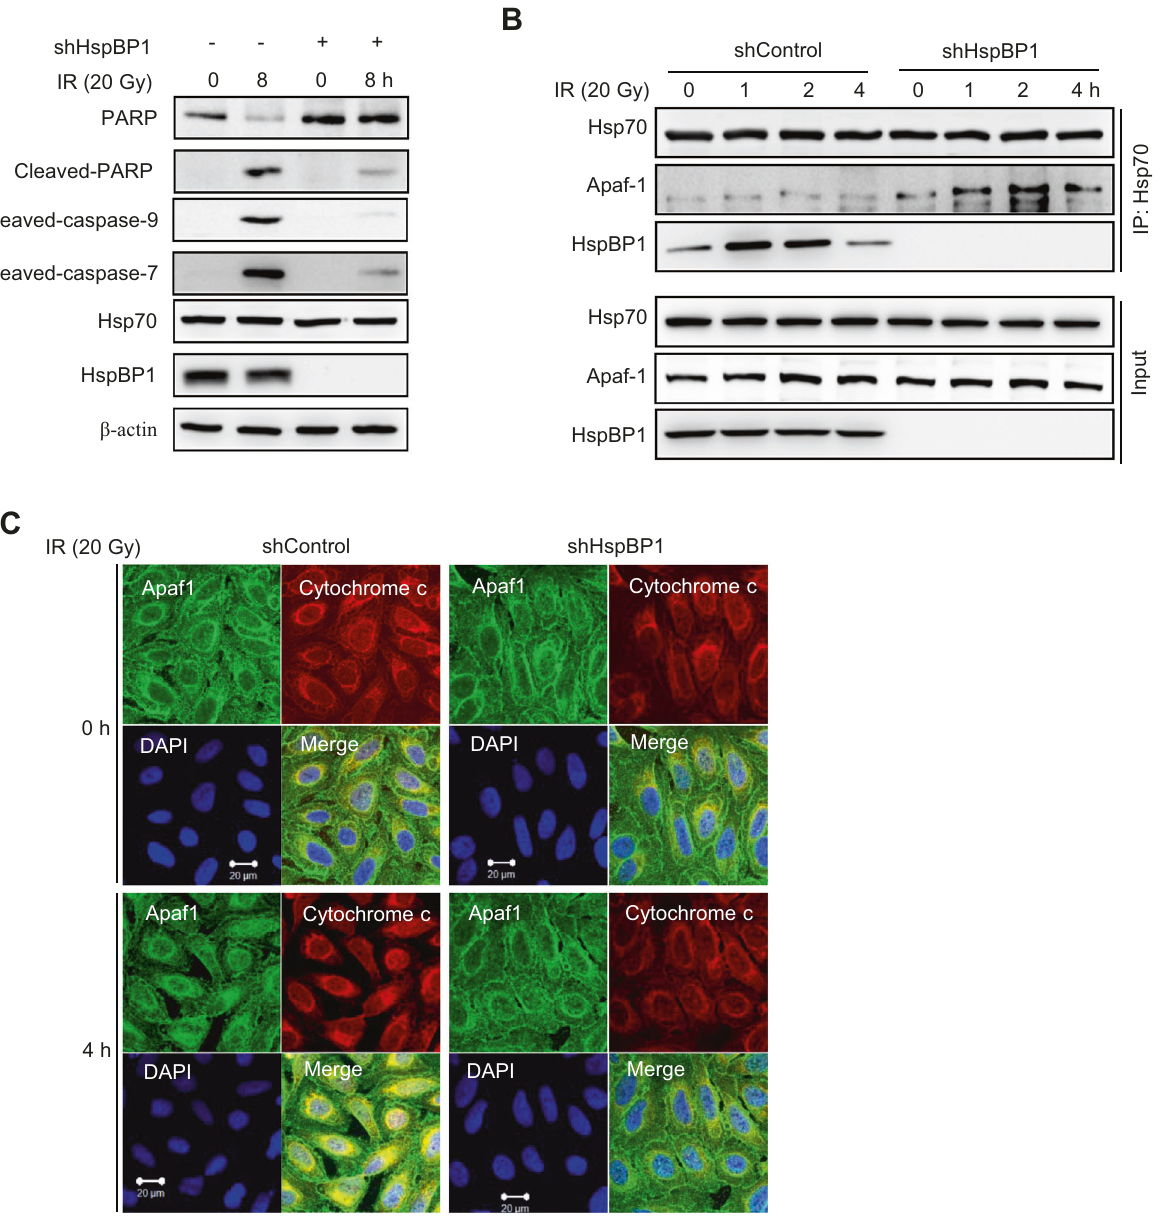
Fig. 7 HspBp1 depletion inhibits IR-induced apoptosis. A Control and HspBP1-depleted cells were either untreated or treated with 20 Gy of IR for 8 h, after which whole cell lysates were subjected to western blotting using the indicated antibodies. B Control and HspBP1-depleted cells were either untreated or treated with 20 Gy of IR and lysed at the indicated time points. Whole-cell lysates were subjected to immunoprecipitation using anti-Hsp70 antibodies followed by immunoblotting using anti-Apaf-1, anti-Hsp70, and anti-HspBP1 antibodies. C Control and HspBP1-depleted cells were either untreated or treated with 20 Gy of IR for 4 h, after which they were fi xed and immunostained using anti-Apaf-1 and anti-cytochrome c antibodies. Colocalization of Apaf-1 (green) and cytochrome c (red) is visible as yellow. A representative image is shown. Nuclei were stained with